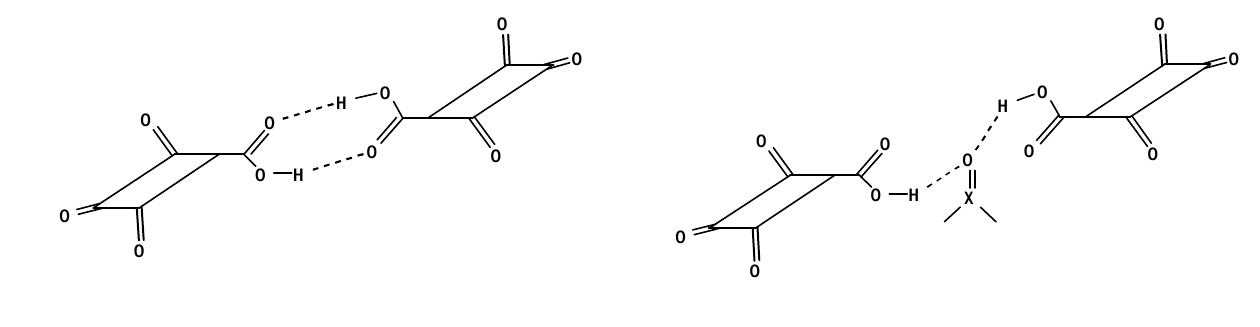
Figure 2. Assembly of 1 a -form as obtained by X-ray analysis and proposed assembly for inclusion solvents in 1